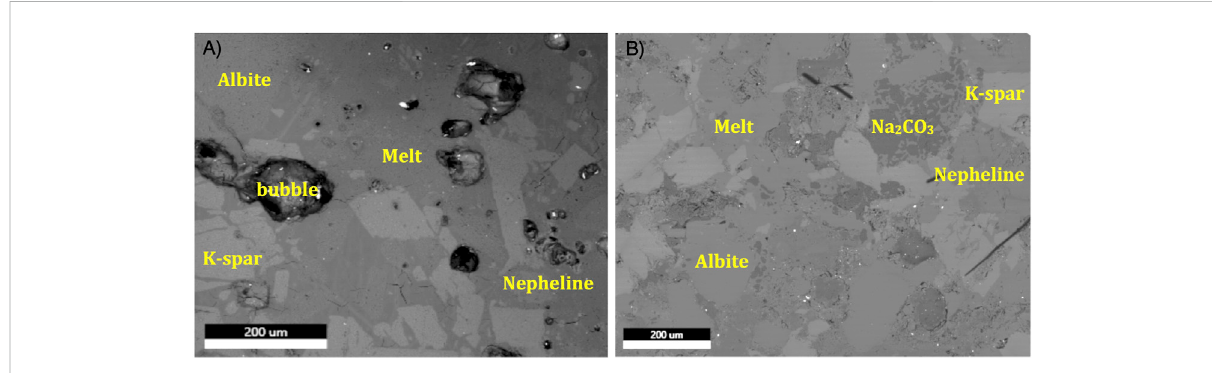
FIGURE 3 BSE images of isothermal crystallization experiments at 0.1 GPa. (A) Nepheline-albite-microcline-DS at 630 ° C; Note prominent vapor bubbles. (B) Nepheline-albite-microcline-DS +